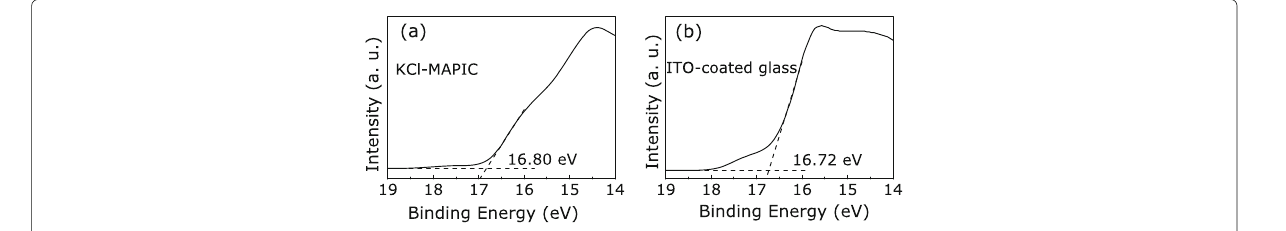
Fig. 8 Cut-off regions of a the KCl-MAPIC film and b the ITO-coated